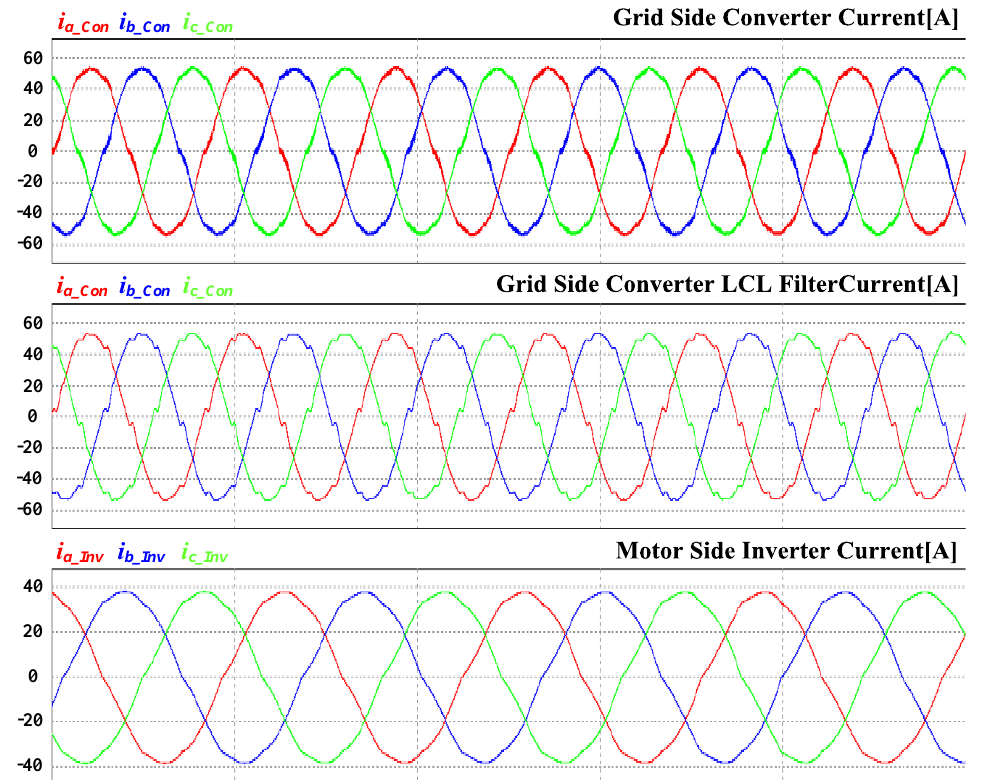
Figure 16. Simulation results of grid side current, LCL filter current, and three-phase motor current using the conventional SVPWM with dead time.